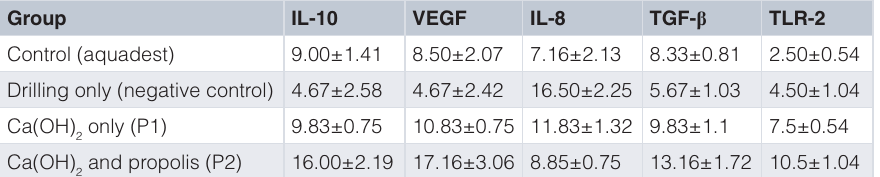
Table 2. IL-10, VEGF, TGF- β and TLR-2 expression in rats treated with various concentrations of propolis and calcium hydroxide for 14